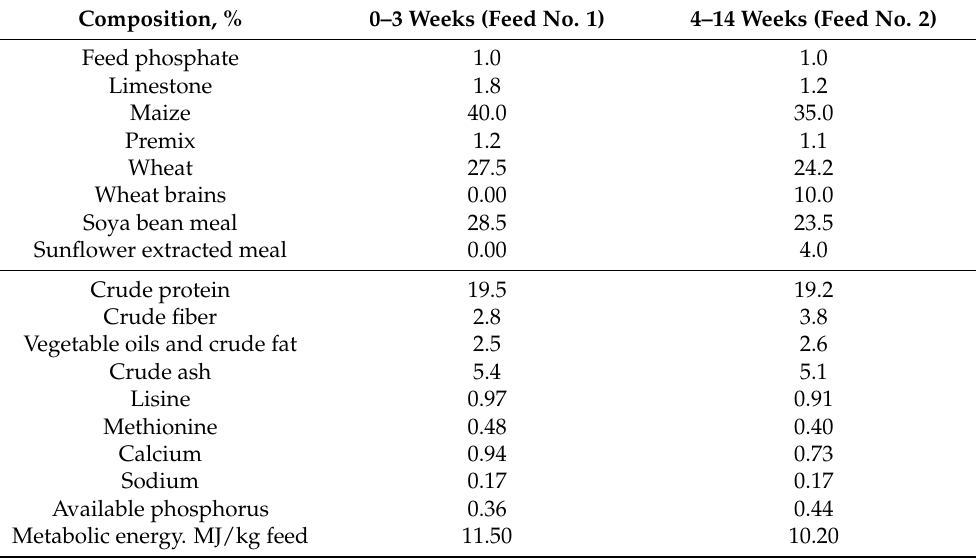
Table 2. Composition of concentrates and chemical composition of feed used in geese feeding.